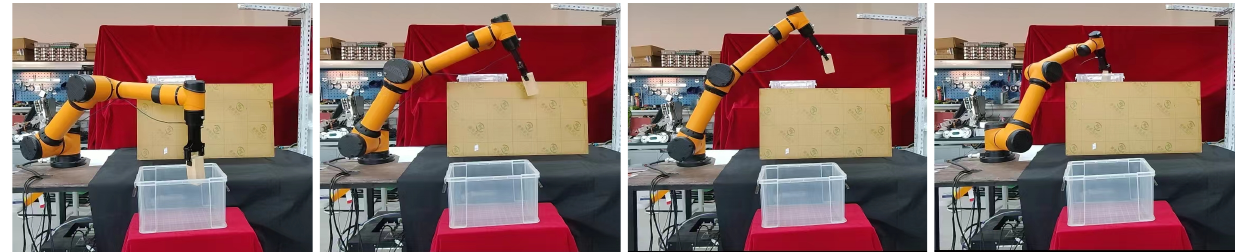
Figure 13. The path sequence of AUBO − i5 when it is about to perform placing task.